Question: Describe this figure in one sentence.
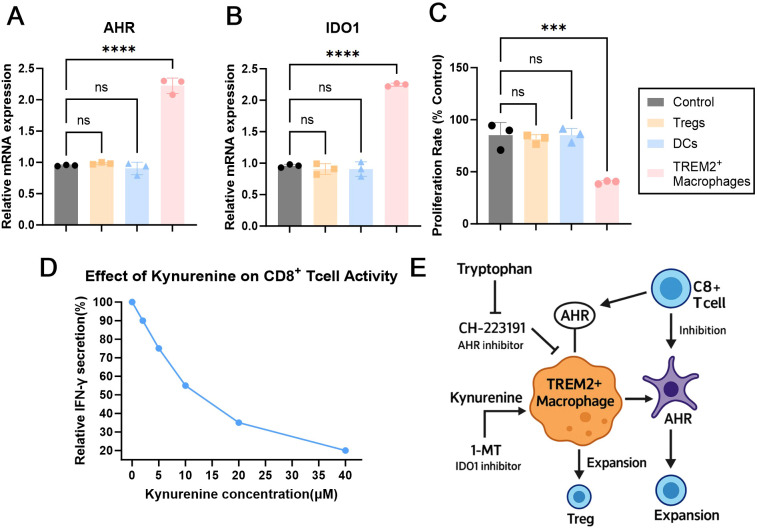
Answer: Dominant role of TREM2 + macrophages in the AHR-IDO1-Kyn immunometabolic axis. (A, B) RT-qPCR analysis of AHR and IDO1 gene expression levels in different immune cell populations (Control, Tregs, dendritic cells, and TREM2 + macrophages); (C) T cells were co-cultured with the indicated immune cell populations, and proliferation rates were assessed using CFSE dilution assays; (D) fitted curve illustrating the relationship between CD8 + T cell functional activity and Kyn concentration; (E) schematic illustration of the functional role of TREM2 + macrophages in the tryptophan-Kyn metabolic pathway. All in vitro experiments were repeated three times. ns, p > 0.05; ***p < 0.001; ****p < 0.0001. * indicates statistical significance between groups; ns, > 0.05; *** p < 0.001.